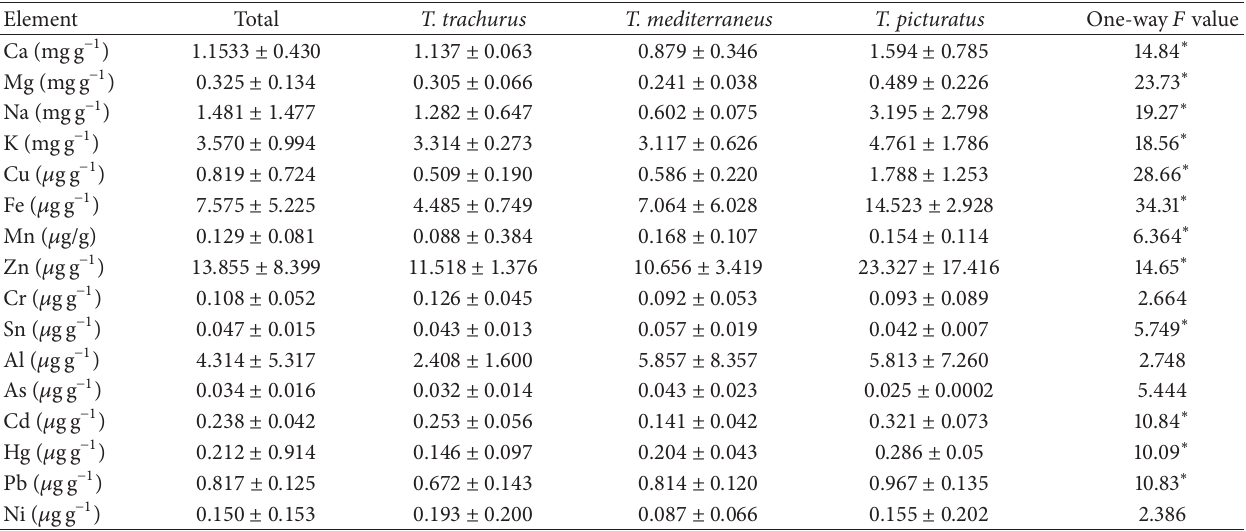
Table 4: Concentration of metals (mgg − 1 and 𝜇 gg − 1 wet weight) in fish species studied average concentrations ± standard deviation.